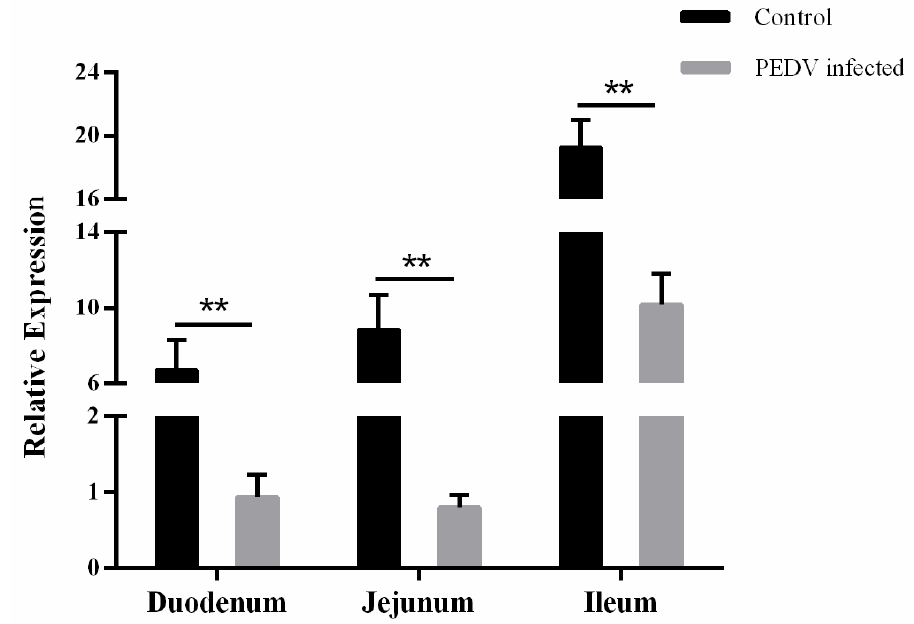
Figure 2. AQP3 gene expression in gut tissues from porcine epidemic diarrhea virus (PEDV)-infected diarrheic and normal piglets. Bars represent mean ± standard deviation ( n = 3). *, p <0.05; **, p <0.01.